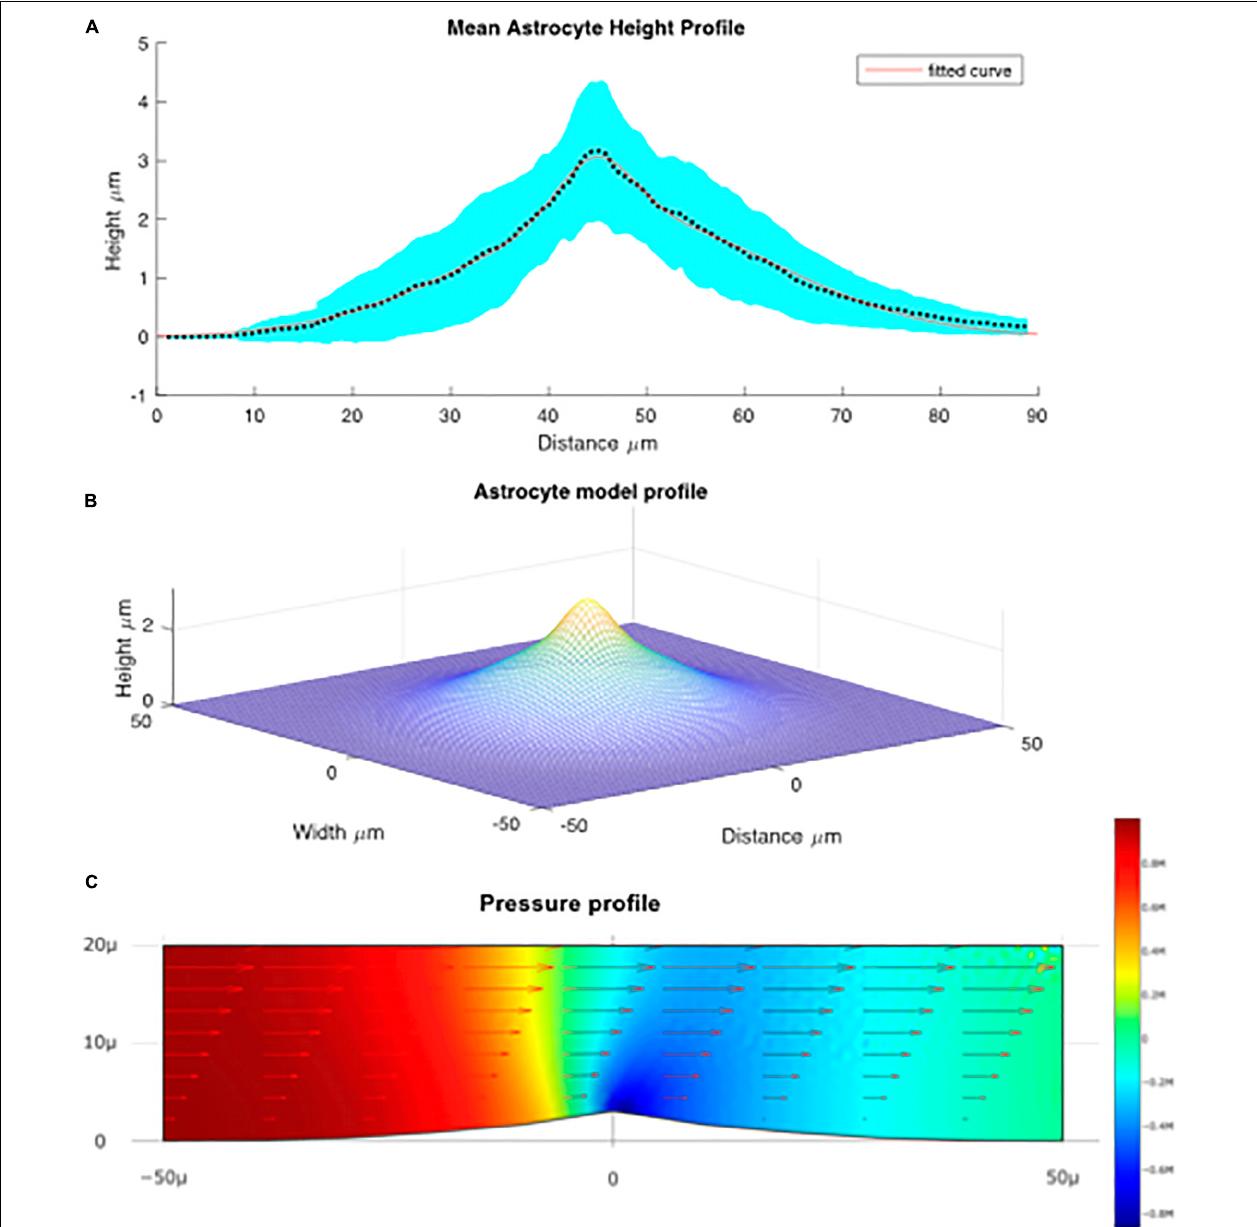
FIGURE 4 | (A) Mean height profile of astrocytes derived from QPM data depicted by the dotted line. The red line denotes the fitted Gaussian function. The blue shaded area is the standard error derived from the QPM height profiles. (B) Model of the average astrocyte height profile used for modeling fluid flow over the cells. (C) Computed flow over the astrocyte cell. Arrows denote the fluid velocity, color denotes